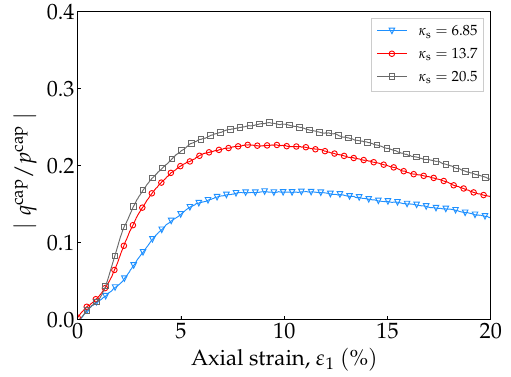
= 10 − 3 , κ = 0 . 42, κ = 13 . t 0 /κ r s 0